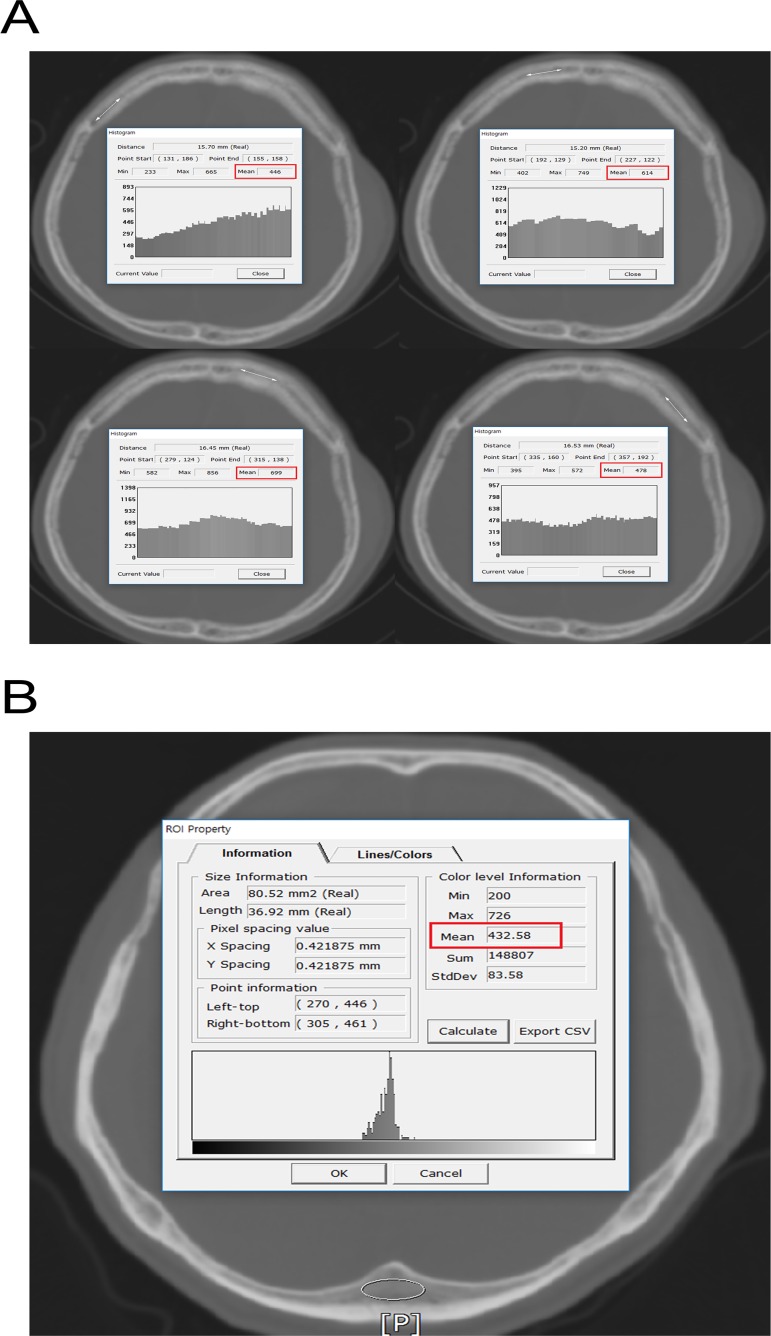
Measurement of HU values at frontal bone and IOP.(A) Measurement of HU values at each of four lines on the frontal bone (right lateral, right medial, left medial, and left lateral). The PACS automatically calculated the maximum, minimum, and mean HU values according to the values on the drawn line, and the mean HU value on each of the four lines was recorded. (B) Measurement of HU values at IOP. The PACS automatically calculated the maximum, minimum, and mean HU values according to the oval ROI. The mean HU value was used for the study. HU = Hounsfield unit; IOP = internal occipital protuberance; PACS = picture archiving and communication system; ROI = region of interest.